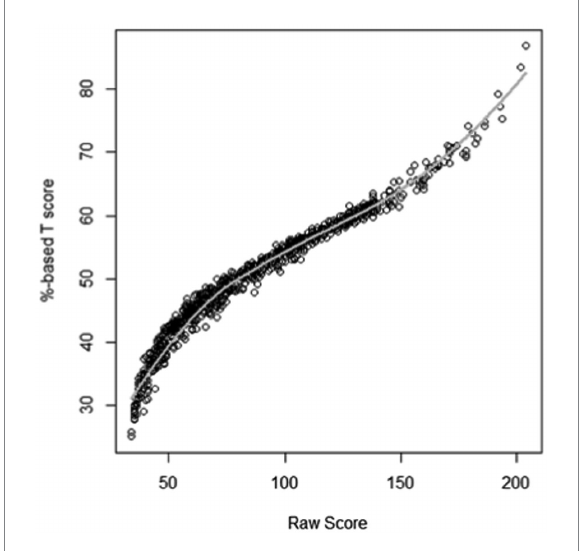
FIGURE 1 Relationship between raw scores and theta-based T -scores on the